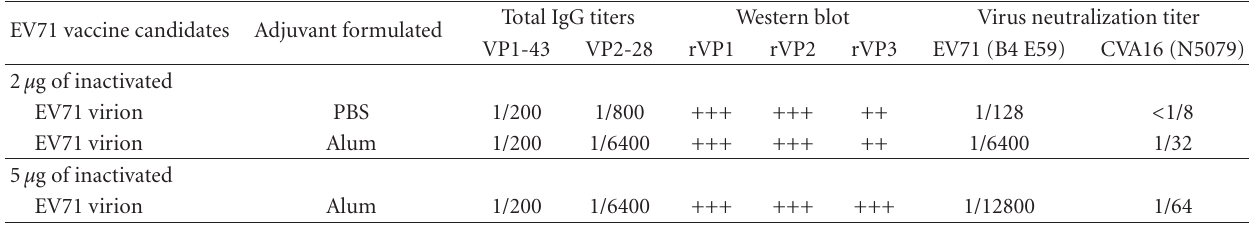
Table 2: Summary of rabbit immunogenicity studies with di ff erent EV71 vaccine candidates.